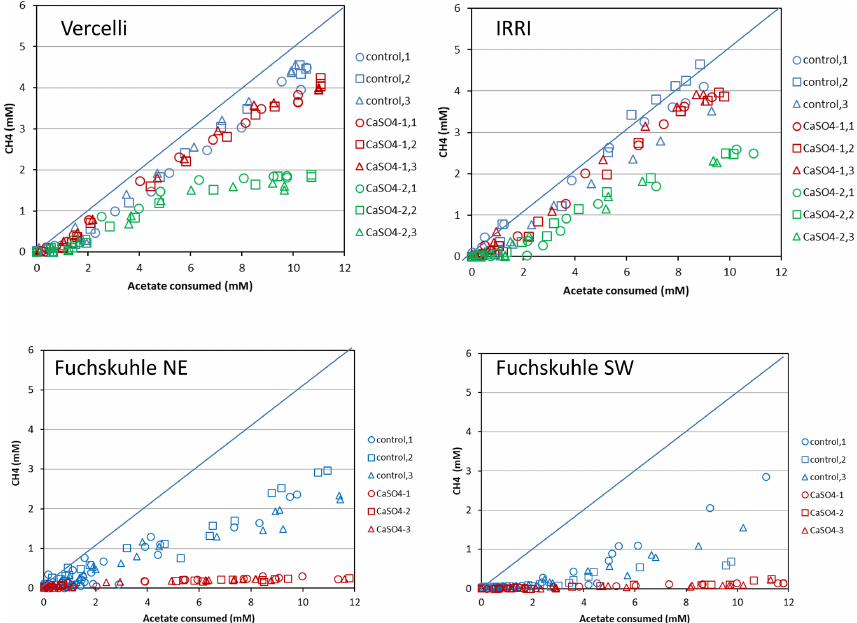
Figure 5. Balance of CH 4 produced against acetate consumed in phosphate-buffered suspensions of paddy soil from Vercelli and the IRRI and of sediments from the northeastern and southwestern basins of Lake Fuchskuhle. The panels show individual replicates ( n = 3) of the unamended control (methanogenic conditions), of the experiment plus gypsum (CaSO 4 -1), and of preincubation and experiment plus gypsum (CaSO 4 -2). The diagonal line indicates stoichiometric conversion (disproportionation) of acetate to CH 4 + CO 2